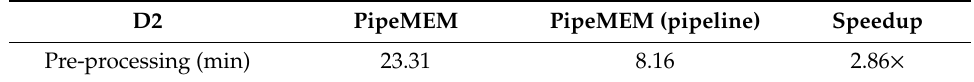
Table 4. Latency of pre-processing in